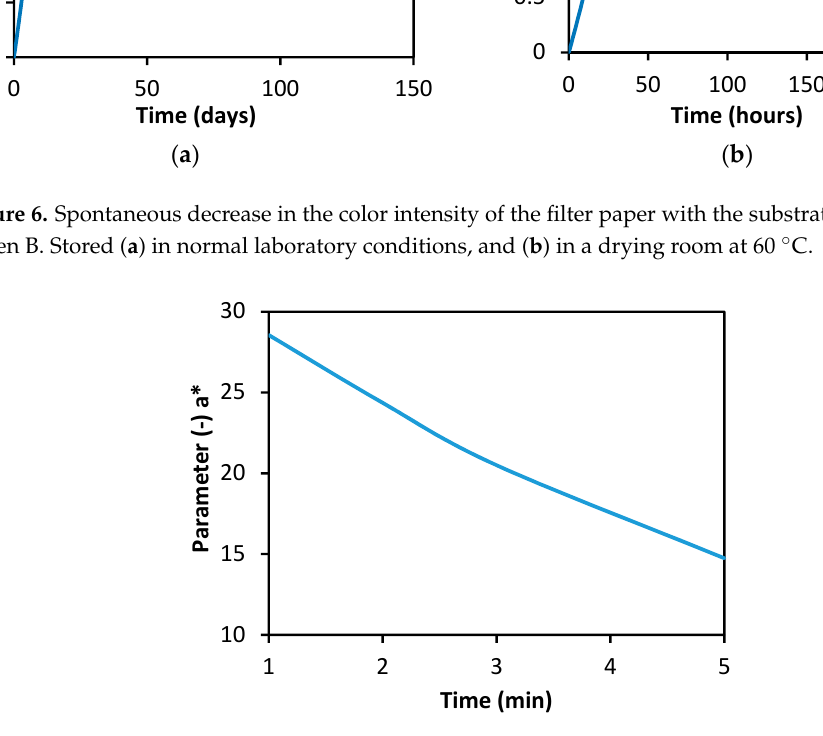
Figure 7. Performance of the modified biosensor with the filter paper impregnated with the substrate and the indicator after exposure to a thermal load of 60 °C for 240 h. The sample contained 10 µg/mL of physostigmine, conditions of measurement: exposure 60 s, carriers separated after 60 s.